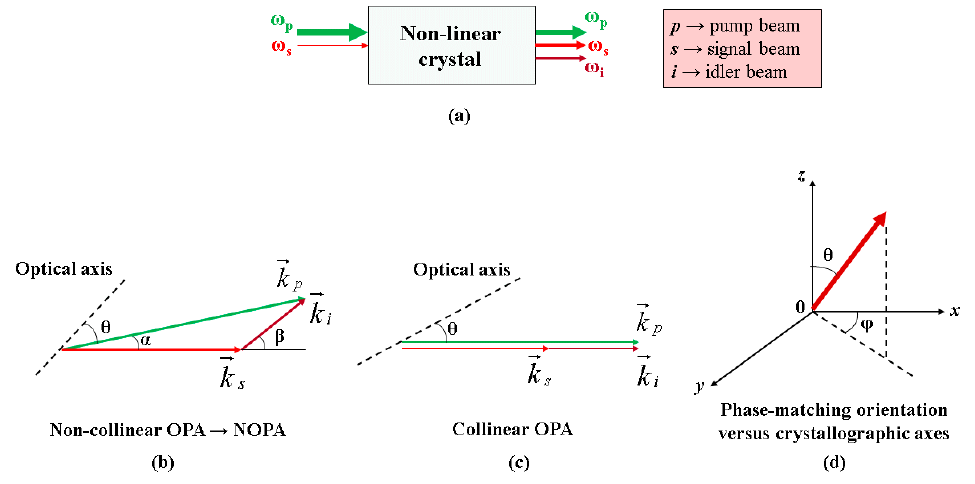
Figure 12. Optical parametric amplification (OPA) in nonlinear crystals. ( a ) The principle of OPA. ( b ) Phase-matching for a non-collinear OPA. ( c ) Collinear OPA. ( d ) Phase matching direction versus crystallographic axes.